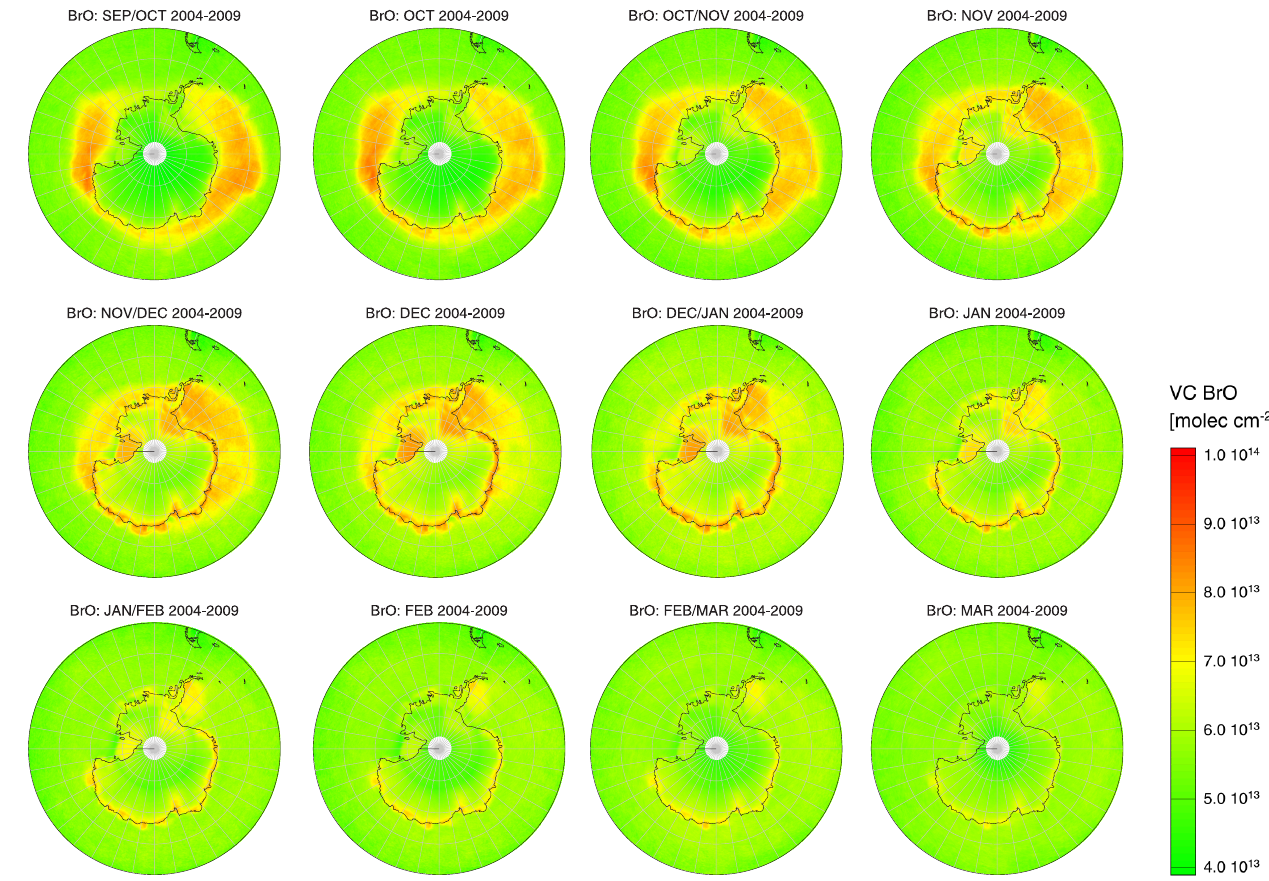
Fig. 5. Monthly maps of BrO vertical column amounts on the Southern Hemisphere (up to 50 ◦ S) averaged over six subsequent years each (2004–2009), the individual averaging periods are given in the headers.